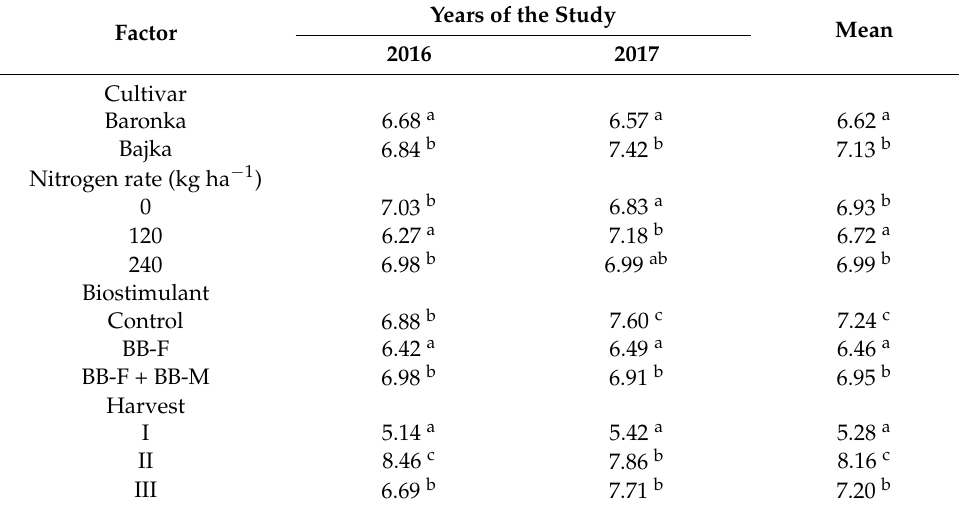
Figure 5. Relationships between the content of potassium (g kg − 1 DM) in the post-harvest biomass of the analyzed perennial ryegrass cultivars vs. nitrogen rate, biostimulant and years of the study (the same letter do not differ significantly at p < 0.05 in Tukey’s HSD test). Table 7. Content of calcium in perennial ryegrass biomass (g kg − 1